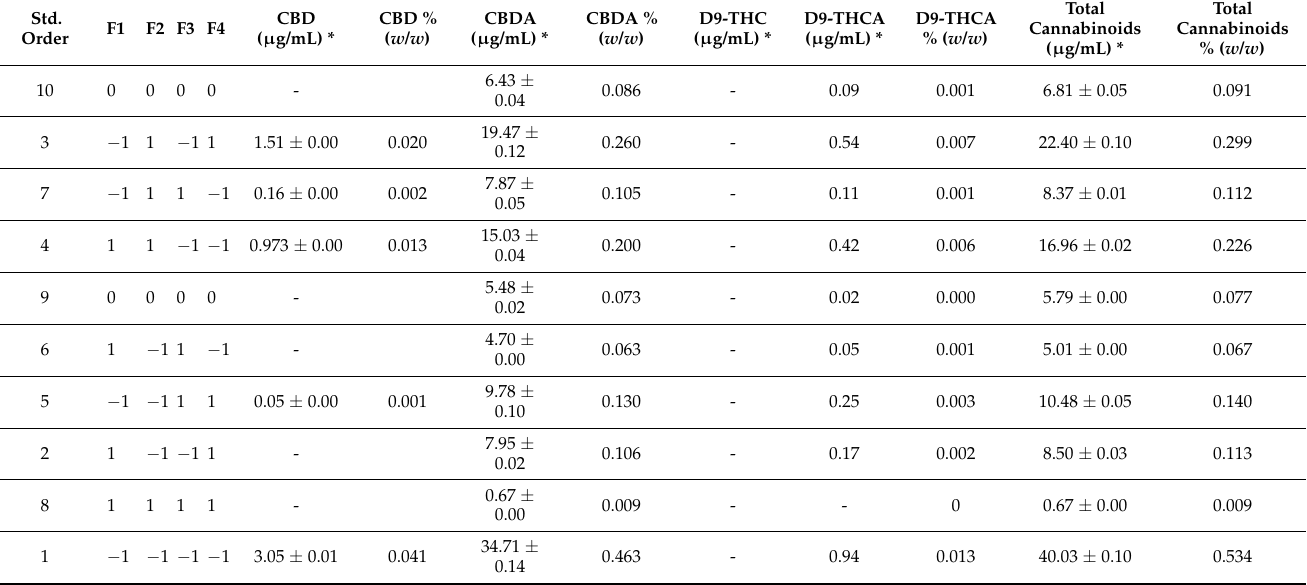
Table 11. Conventional extraction of cannabinoids from the leftover cannabis sample (obtained after factorial design study) for cannabidiol (CBD) and cannabidiolic acid (CBDA), delta 9-tetrahydrocannabinol (D9-THC), delta 9-tetrahydrocannabinol acid (D9-THCA), and total